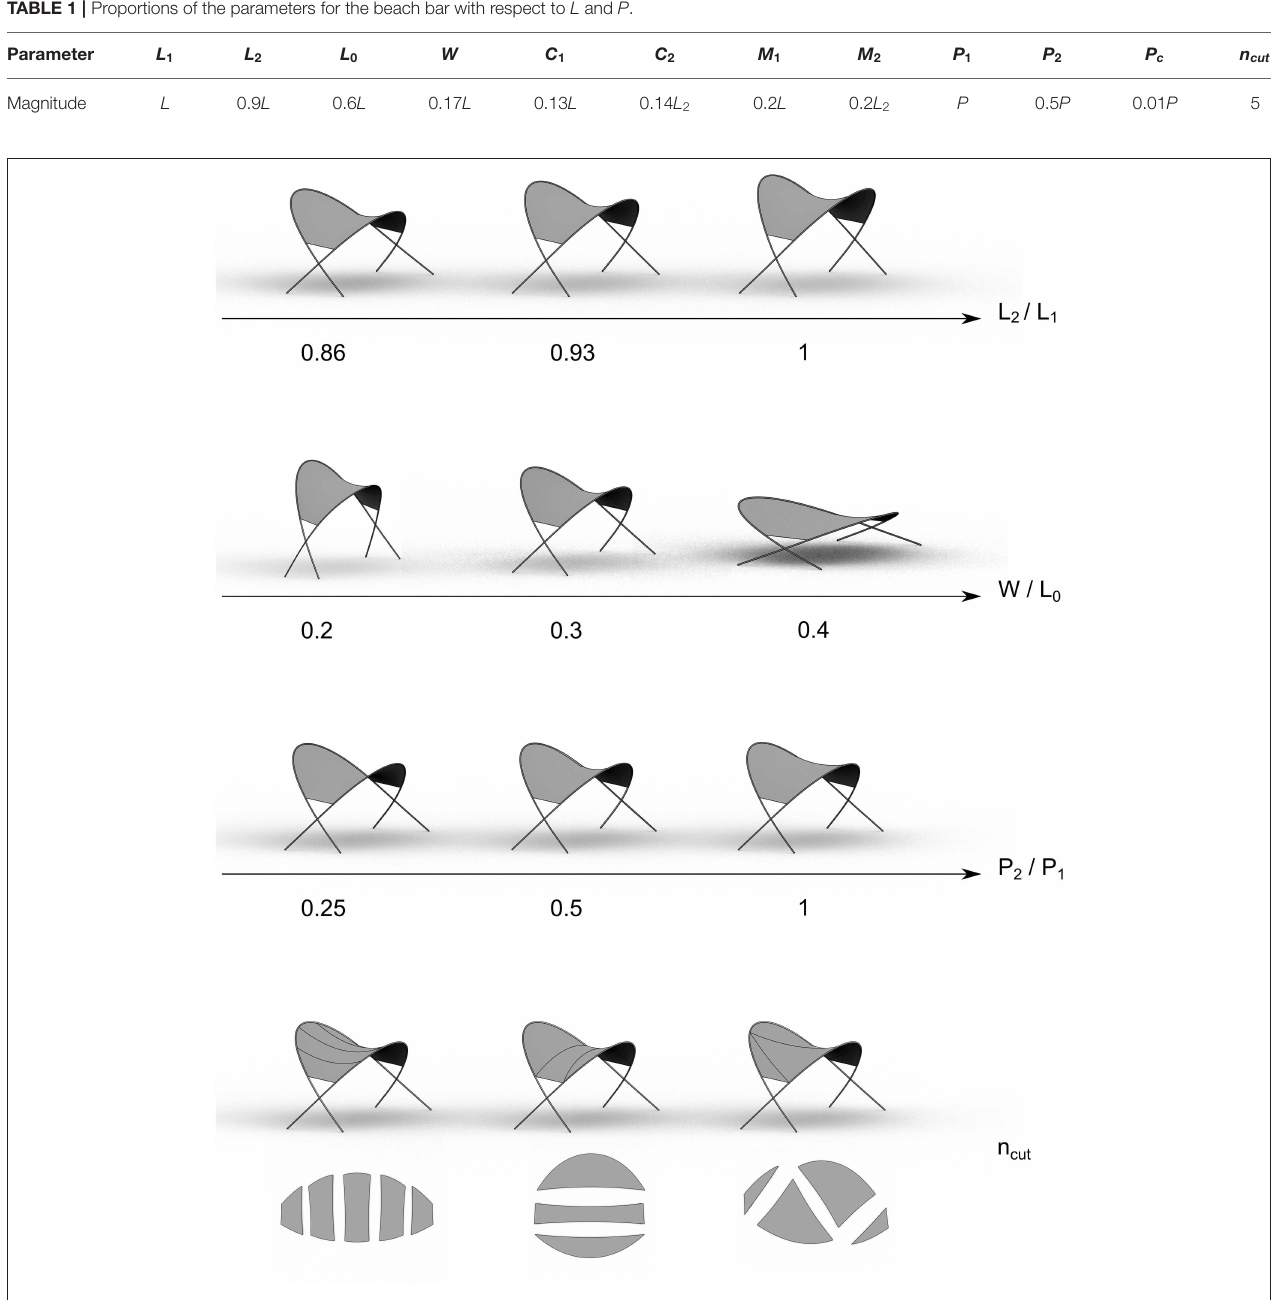
FIGURE 11 | Selected parametric studies of the beach bar with Kiwi!3D for alterations of the proportions of L 2 / L 1 , W / L 0 , P 2 / P 1 , and orientation of n cut